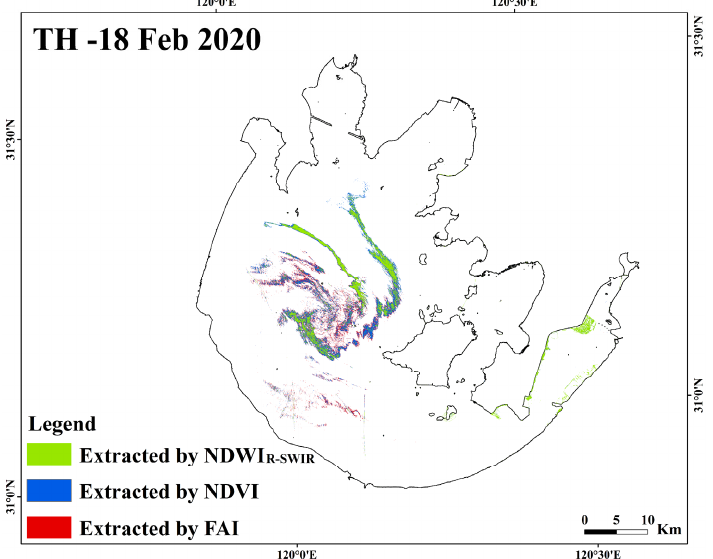
Figure 9. Extraction results of different indices by the decision tree for Lake Taihu on 18 February 2020. The order of decision tree extraction here is to extract first with NDWI R ‐ SWIR , then with NDVI for the remaining part, and finally with FAI.